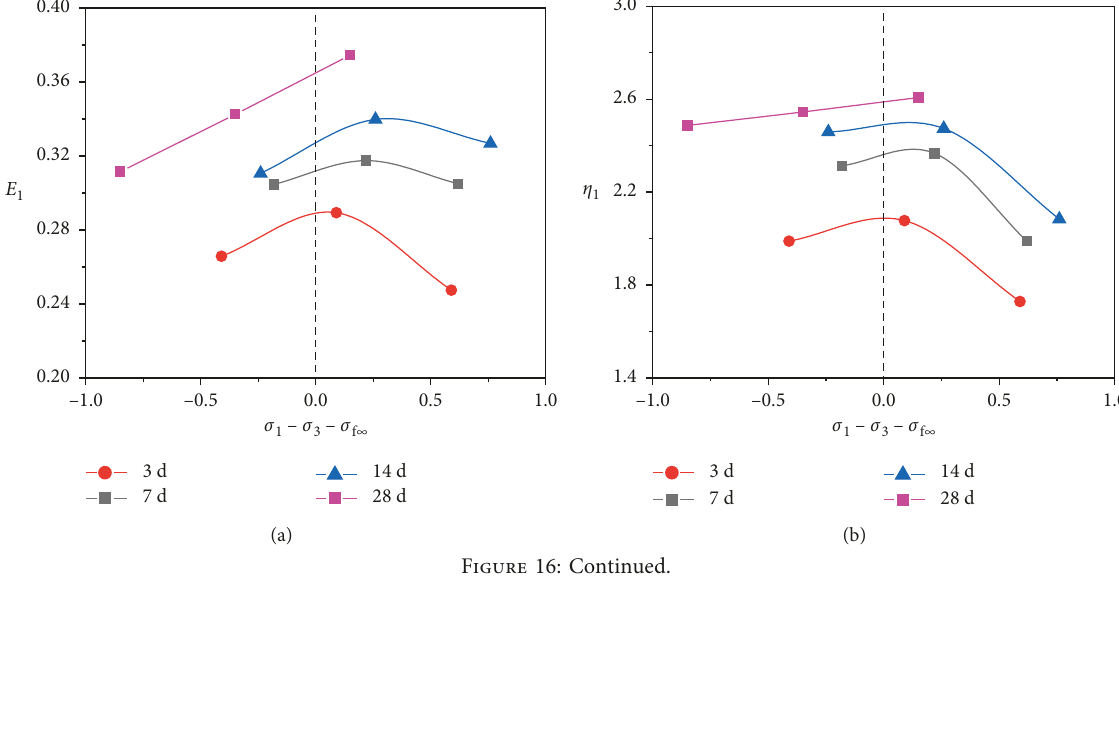
� 8MPa): (a) E 1 1 , (b) η 1 , (c) η 2 , and (d) e